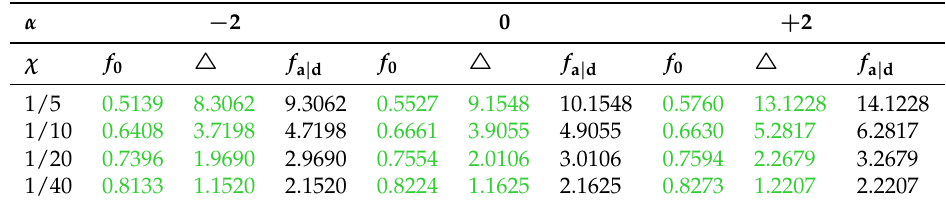
Table 1. Optimized hydrogel dynamic vibration damping properties in green at C = 0 with